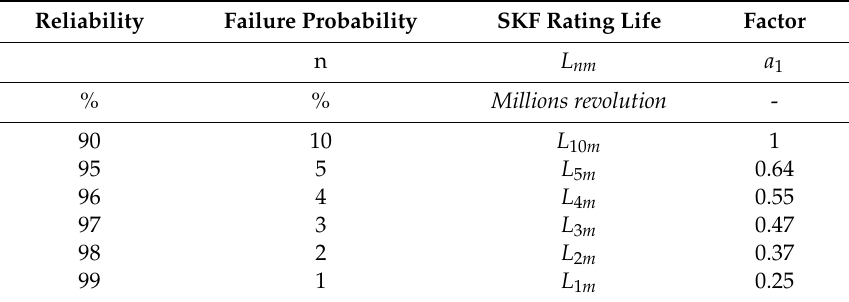
Table A4. Values of the life adjustment factor a 1 [37].